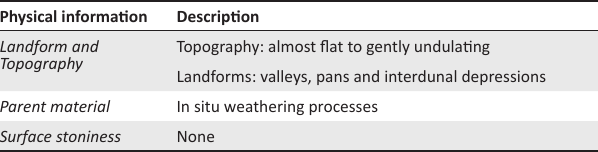
TABLE A1.4a: Differentiating characteristics of the haplic Calcisols.